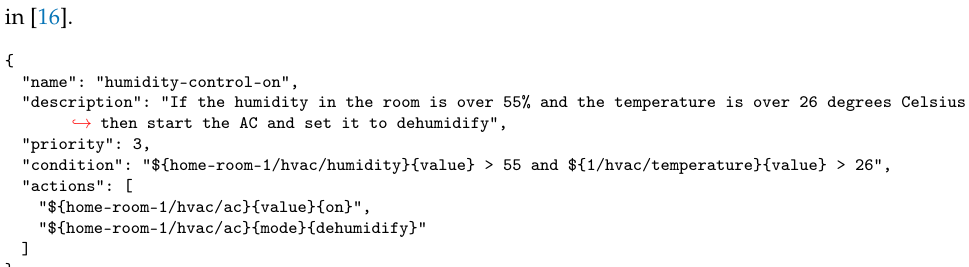
Listing 1. Example of a rule for HVAC in JSON string format based on the rule engine described in